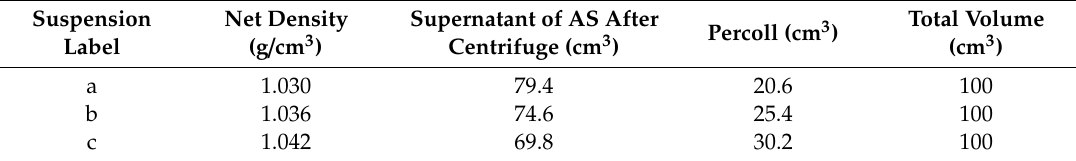
Table 2. Density Composition of Suspensions.